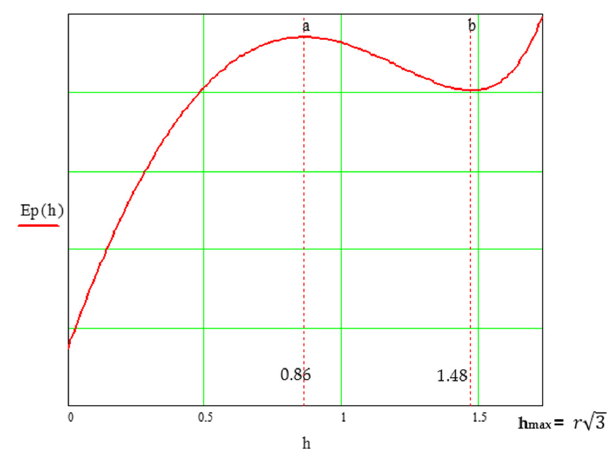
Figure 3. Potential energy graph for k = 6.5 N/m.